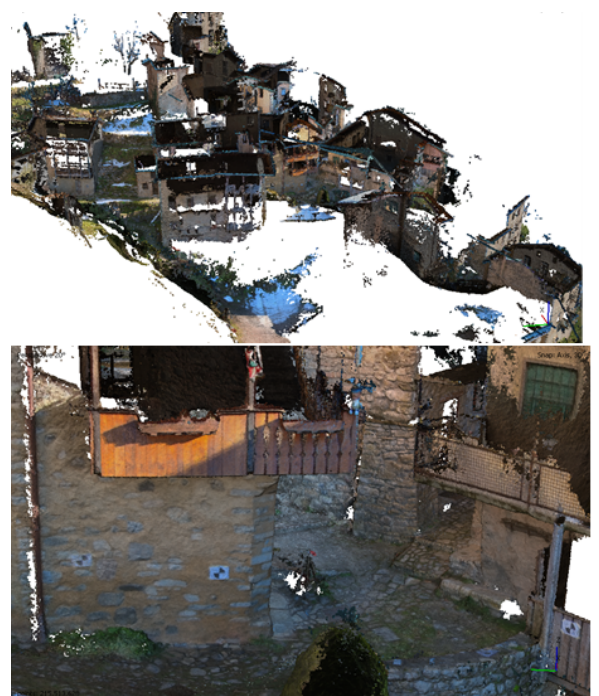
Figure 14: Dense cloud reconstructed for the Erve/Nesolio dataset.